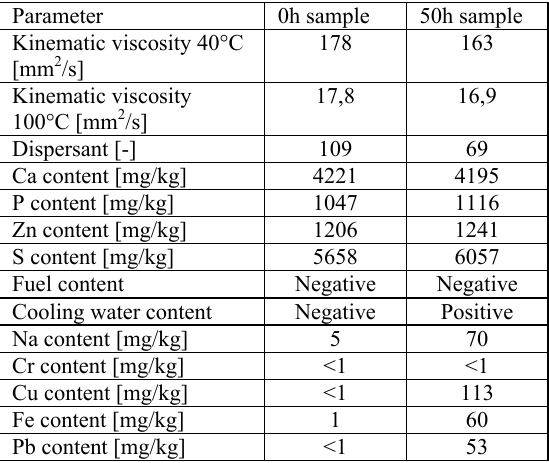
Table 2. Comparison of the LubCheck results of the 0h reference and 50h engine oil sample